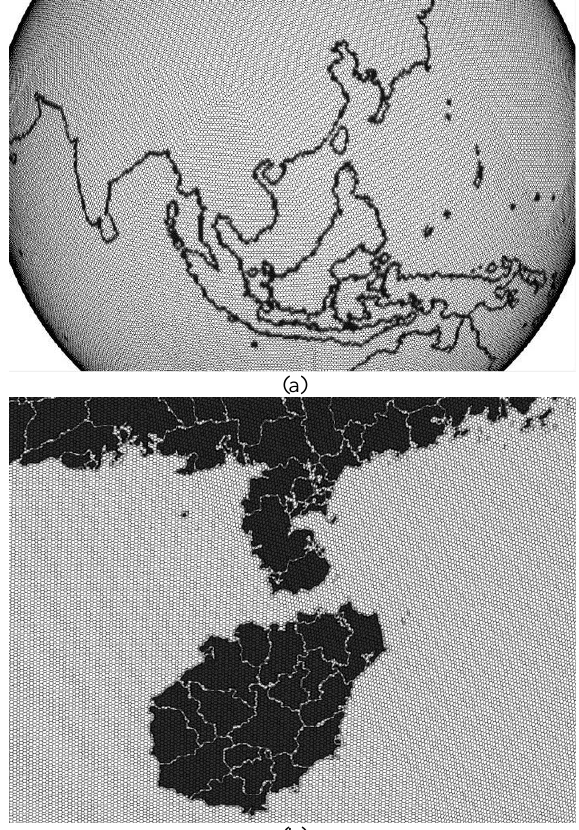
Table 10. Efficiency comparisons of line filling and area filling of vector data